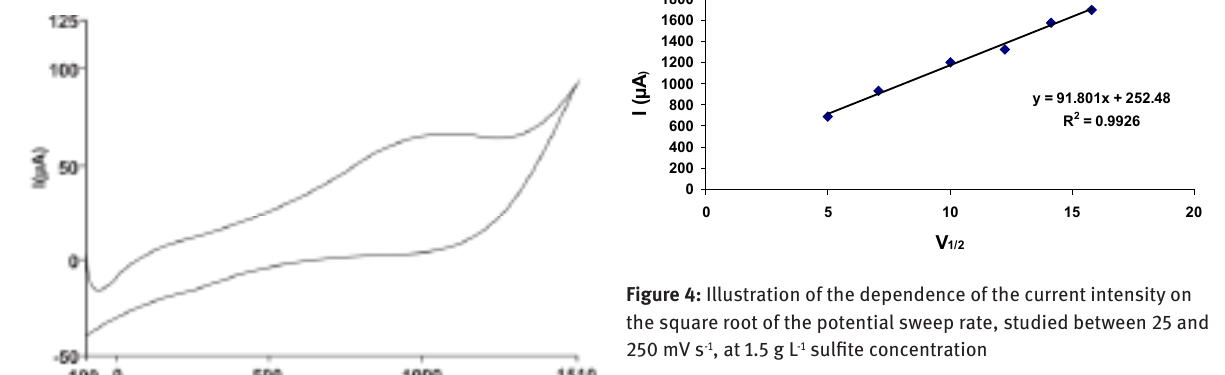
Figure 1: Cyclic voltammogram obtained at the Pt strip electrode Radelkis, for 250 mg L -1 sulfite using as electrolyte 0.1 mol L -1 KCl; scan rate=50 mV s -1